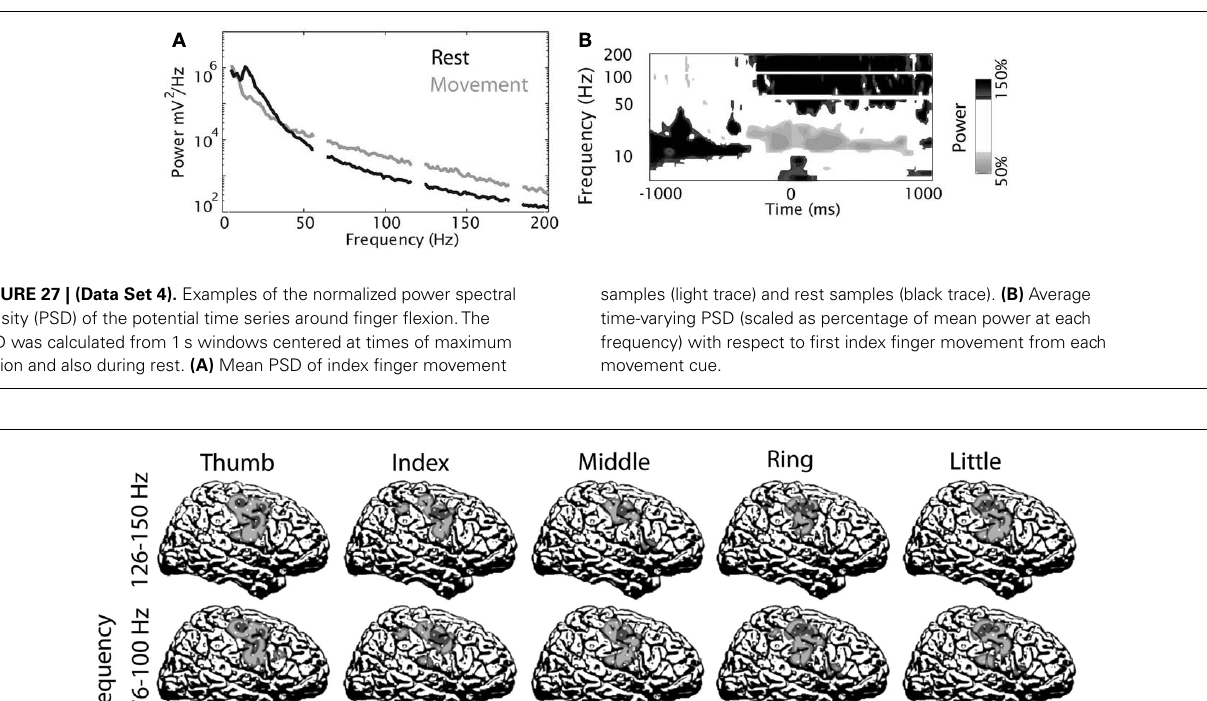
FIGURE 28 | (Data Set 4). Cortical activation maps for movement of different fingers in one subject.The changes in power between 126 and 150Hz are focused in the classic hand area of the brain.The spatial distribution for 76–100Hz are nearly identical, as might be expected since both are reflections of the broadband feature highlighted in recent literature (Miller et al., 2009b). Low frequency changes are